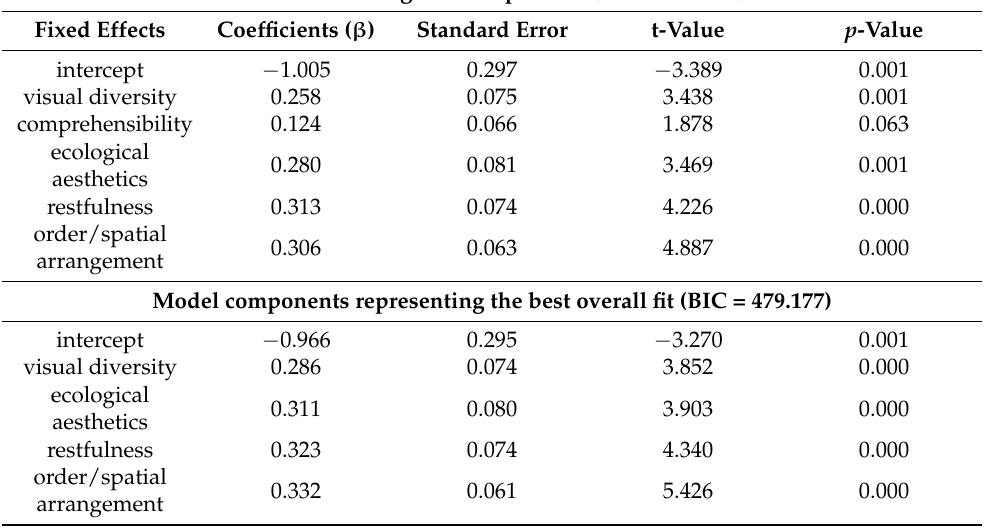
Table 6. Coefficients and significance values for linear mixed models (LMM) explaining the accep- tance of forest views by (a) all components of perception and (b) the two most relevant components. (BIC—Bayesian information criterion, β —unknown coefficient of fixed effects, p -values—level of sig-